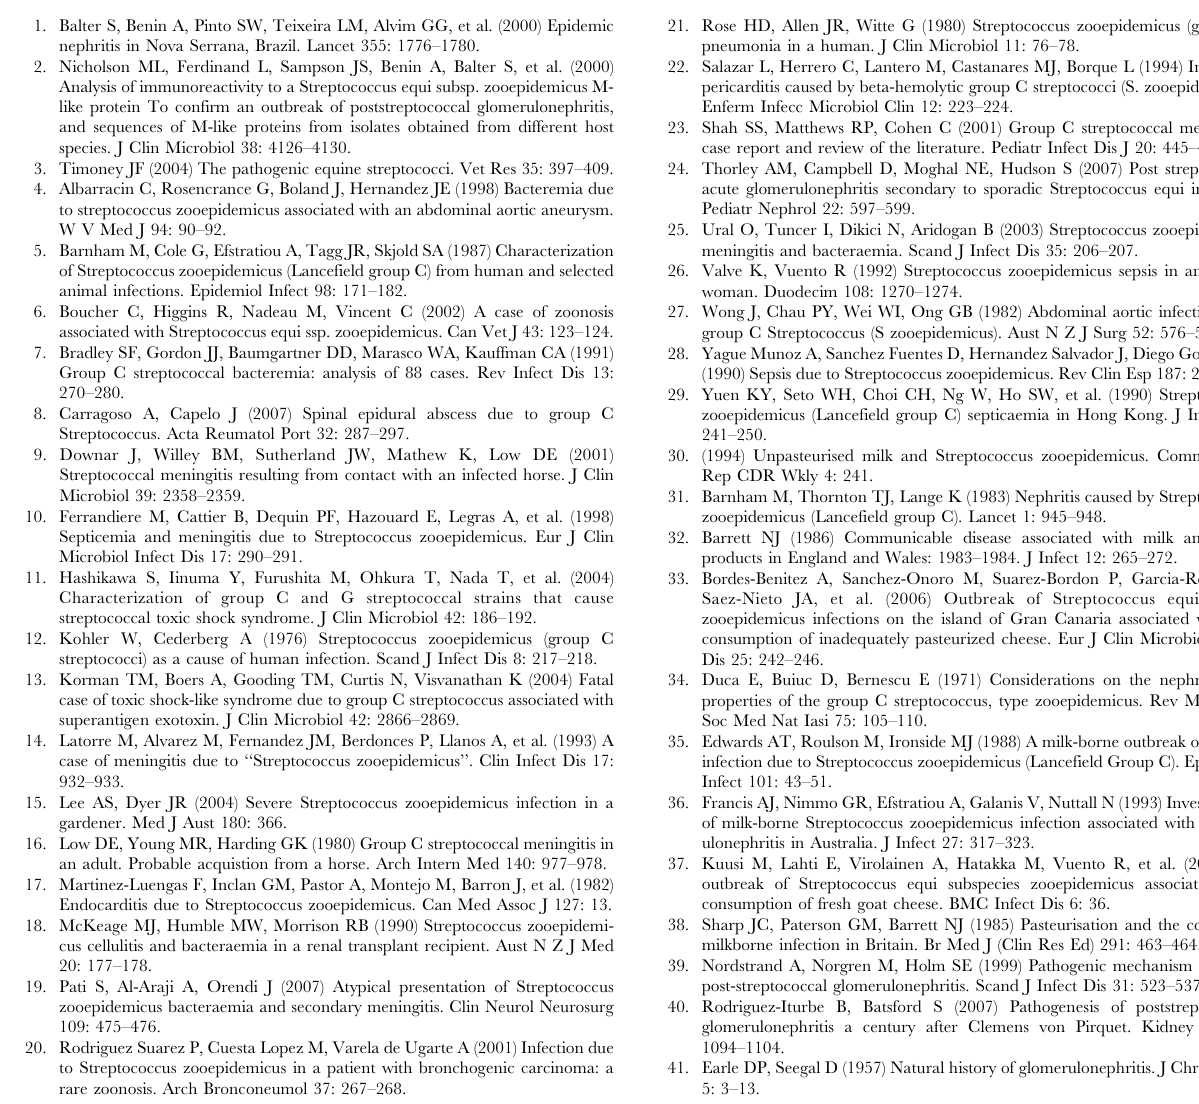
the MGCS10565 genome. Bars show the ranges of values, boxed horizontal lines show the means, and the boxes show the standard errors about the means. Accompanying tables give results of unpaired t-test with Welch’s correction.